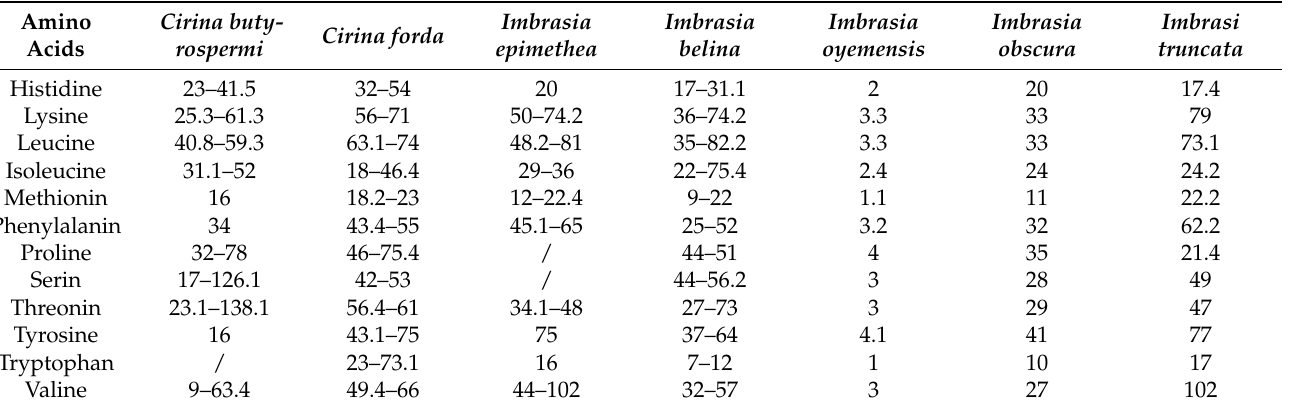
Table 4. Amino acid composition of caterpillars consumed in sub-Saharan Africa (in mg/g dry matter